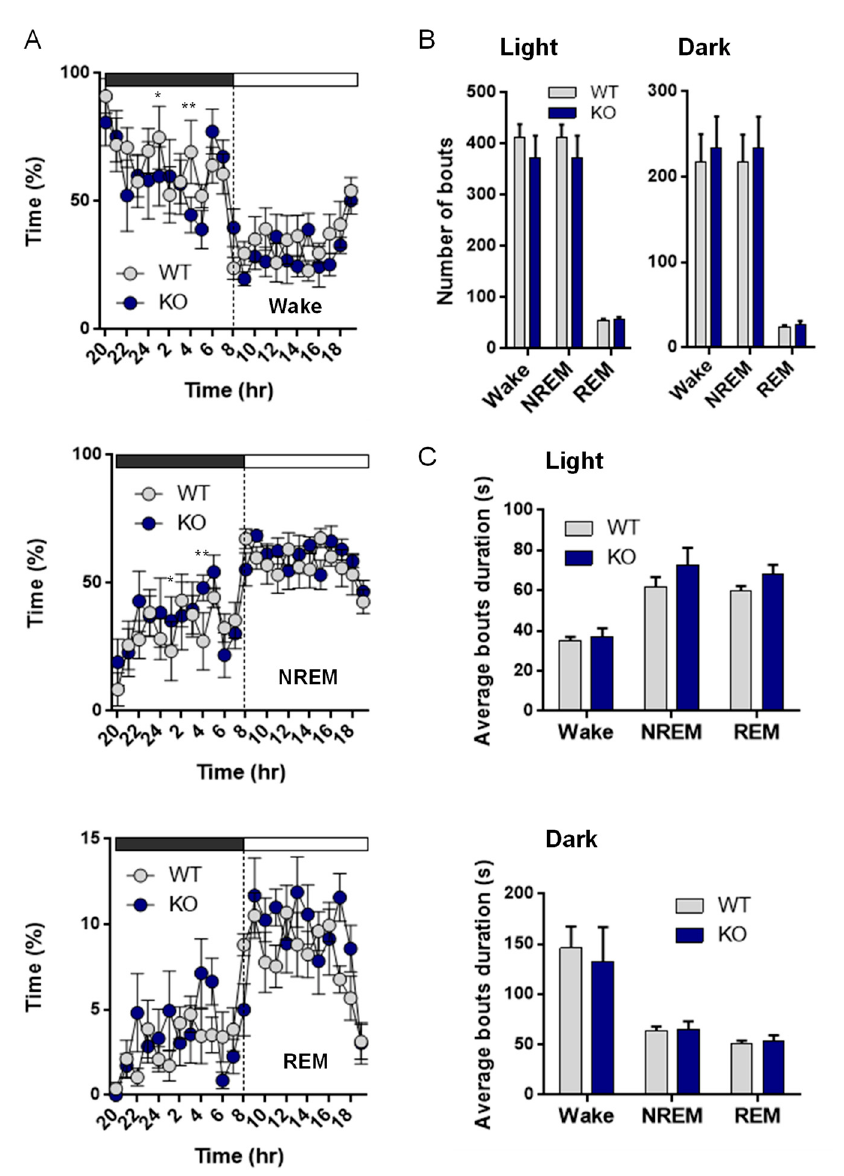
Figure 6. Sleep architecture analysis in VMAT2 DBHcre mice. ( A ) Hourly percentage of time over a 24 h period during the dark (grey) and the light cycle (white) spent in wake (top; genotype: F (1,138) = 0.46, p = 0.52; hour: F (23,138) = 7.03, p < 0.001; genotype × hour: F (23,138) = 1.73, p = 0.028; post-hoc test * p < 0,036, ** p < 0,003), non-rapid eye movement (NREM, middle; genotype: F (1,138) = 0.35, p = 0.57; hour: F (23,138) = 6.34, p < 0.001; genotype × hour: F (23,138) = 1.62, p = 0.047; post-hoc test * p < 0.043, ** p < 0.0037) and REM (bottom; genotype: F (1,138) = 2.1, p = 0.2; hour: F (23,138) = 7.01, p < 0.001; genotype × hour: F (23,138) = 1.56, p = 0.062) in WT (n = 6) and KO (n = 5) VMAT2 DBHcre mice. ( B ) Number of bouts spent in wake, NREM and REM during the light (left; genotype: F (1,27) = 1.33, p = 0.26; state: F (2,27) = 99.72, p < 0.001; genotype x state: F (2,27) = 0.39, p = 0.68) and the dark cycle (right; genotype: F (1,27) = 0.26, p = 0.61; state: F (2,27) = 34.03, p < 0.001; genotype × state: F (1,10) = 0.042, p = 0.96) in WT (n = 6) and KO (n = 5) VMAT2 DBHcre mice. ( C ) Average bouts duration in wake, NREM and REM during the light (top; genotype: F (1,27) = 1.33, p = 0.26; state: F (2,27) = 99.72, p < 0.001; genotype × state: F (2,27) = 0.40, p = 0.68) and the dark cycle (bottom; genotype: F (1,27) = 0.27, p = 0.61; state: F (2,27) = 34.03, p < 0.001; genotype × state: F (2,27) = 0.043, p = 0.96) in WT (n = 6) and KO (n = 5) VMAT2 DBHcre mice.